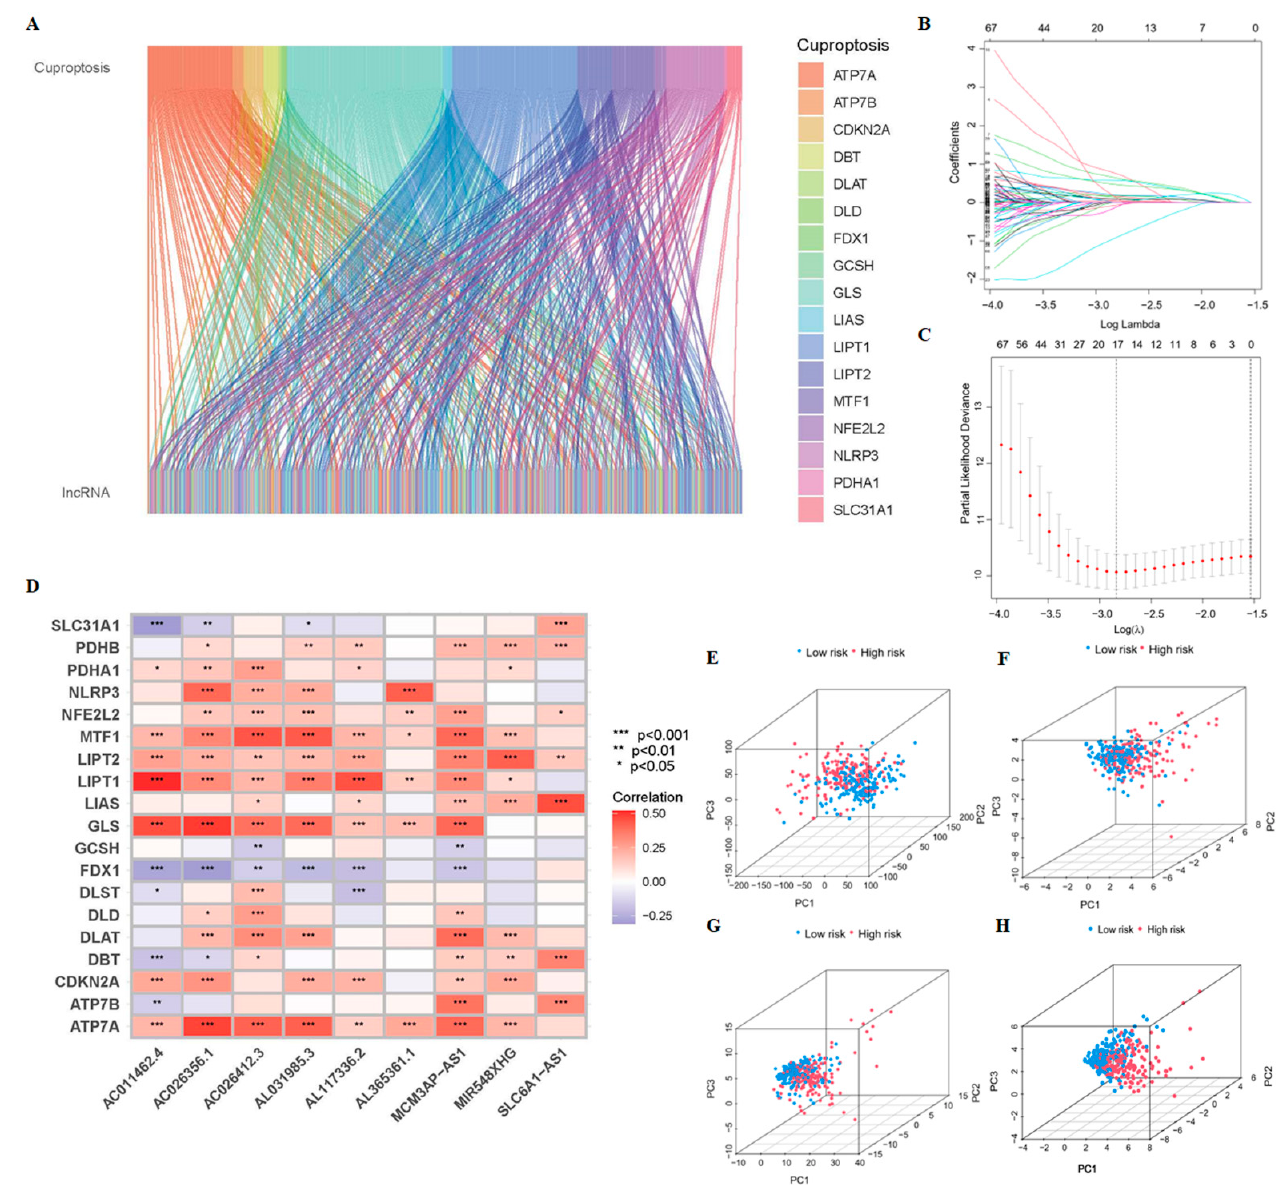
Figure 2. Identification of crLncRNAs in HCC patients, the prognostic model of crLncRNAs and its prediction potential. ( A ) The co-expression network of mRNAs and LncRNAs associated with cuproptosis, which was visualized by Sankey diagram according to Spearman correlation analysis (|R| > 0.4, p < 0.001). ( B ) A cross-validation to adjust the parameter selection in the LASSO Cox regression model. ( C ) The LASSO coefficient curve of 9 crLncRNAs. ( D ) The heatmap of correlation analysis of cuproptosis-related genes and the 9-crLncRNA signatures. * p < 0.05, ** p < 0.01, and *** p < 0.001. Principal components analysis between low- and high-risk groups based on the expres- sions of ( E ) entire genes ( F ) 19 cuproptosis-related genes ( G )147-crLncRNA, and ( H ) 9-crLncRNA. In this model, the following formula was used to calculate the risk score for each HCC patient in the TCGA database: Risk score = AC026412.3 * 2.54199 + AC026356.1 *